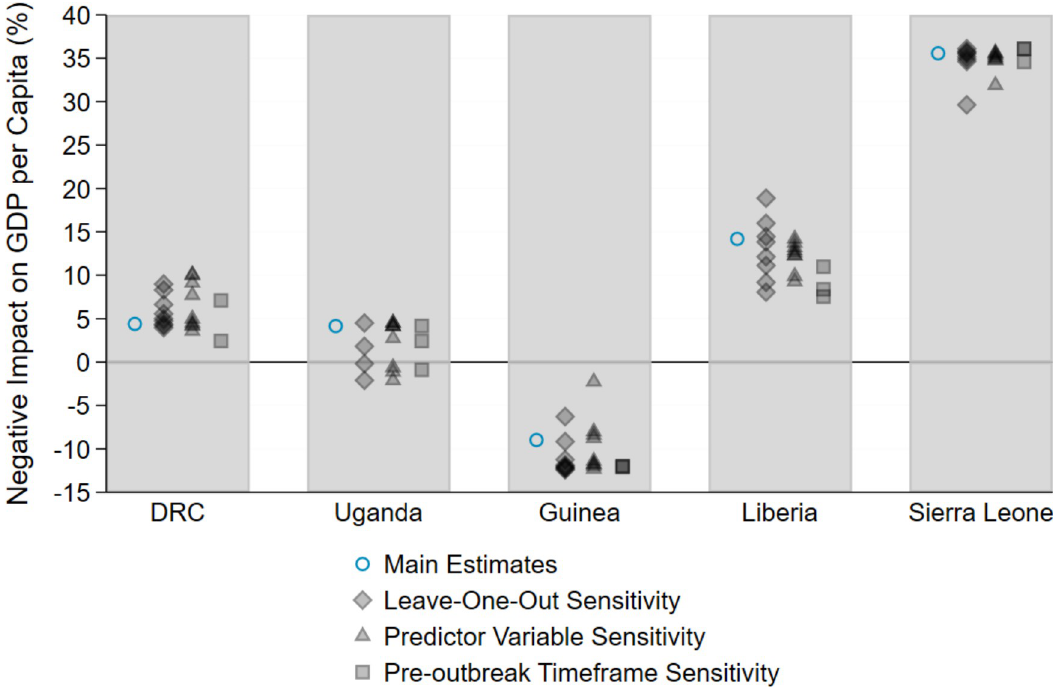
Fig 2. The cumulative effect on GDP per capita accrued by year 3 post-EVD outbreak: Main estimates versus sets of estimates generated from three types of robustness tests. DRC, Democratic Republic of the Congo; EVD, Ebola virus disease; GDP, gross domestic